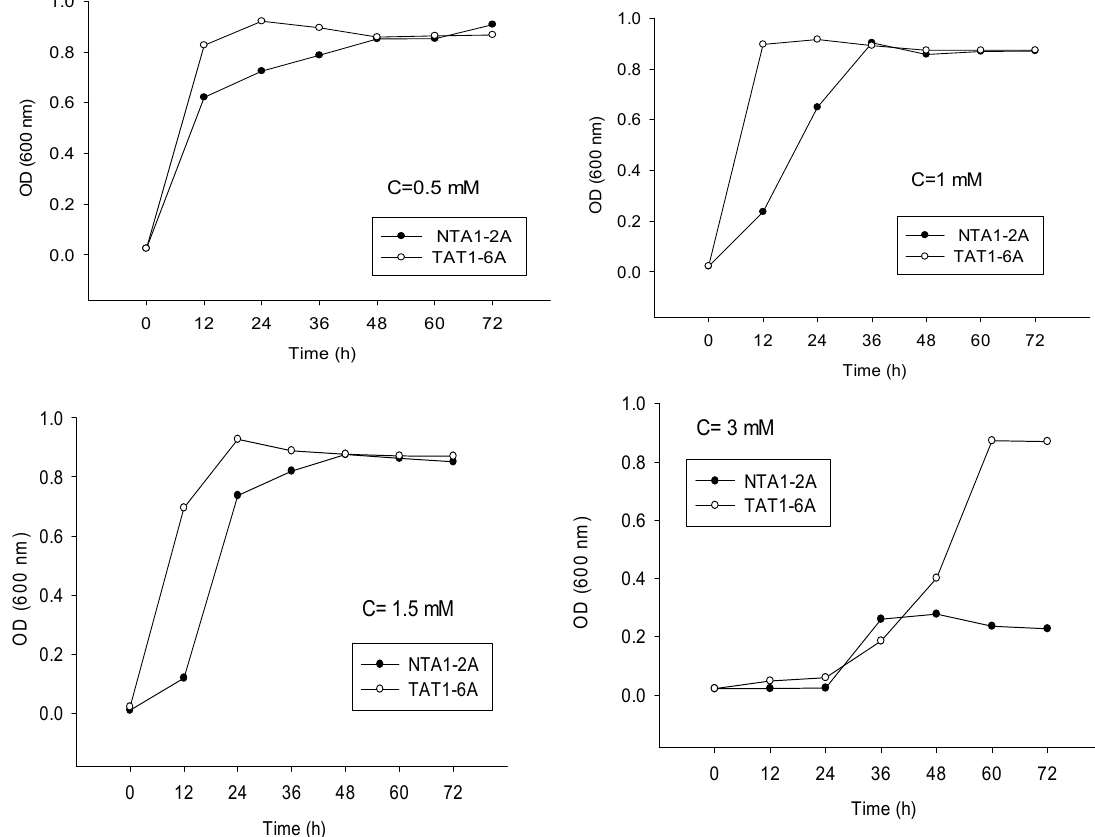
Figure 6. Proliferation of Strains NAT1-2A and TAT1-6A at concentrations (C) of 0.5 mM (58.58 mg / L); 1.0 mM (117.15 mg / L); 1.5 mM (175.73 mg / L) and 3.0 mM (351.45 mg / L) of indole for 72 h.